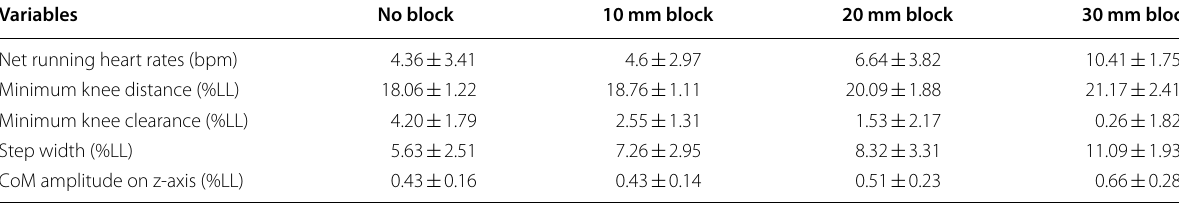
The numbers are listed in format of mean